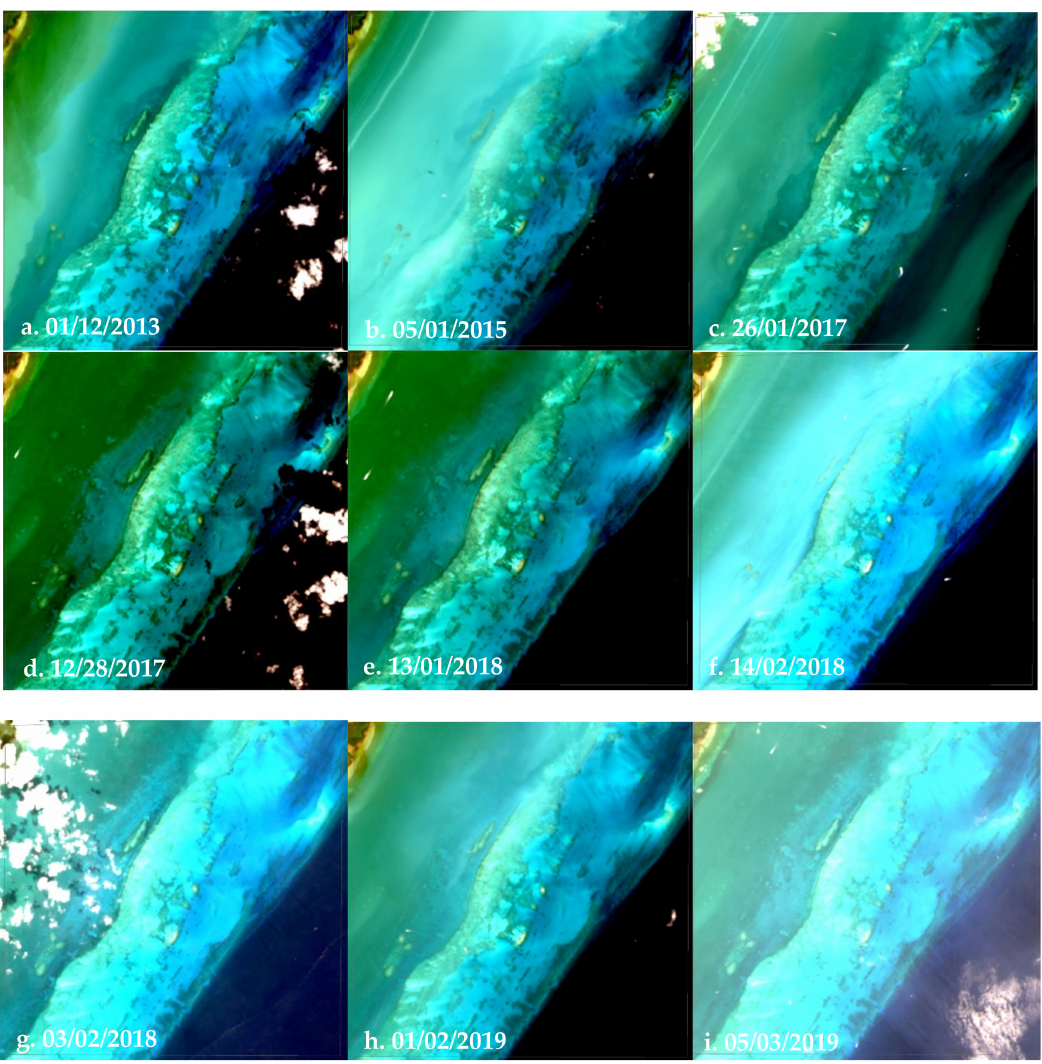
Figure 2. ( a – i ) A section of Florida Keys image showing the RGB composite of each image used in this